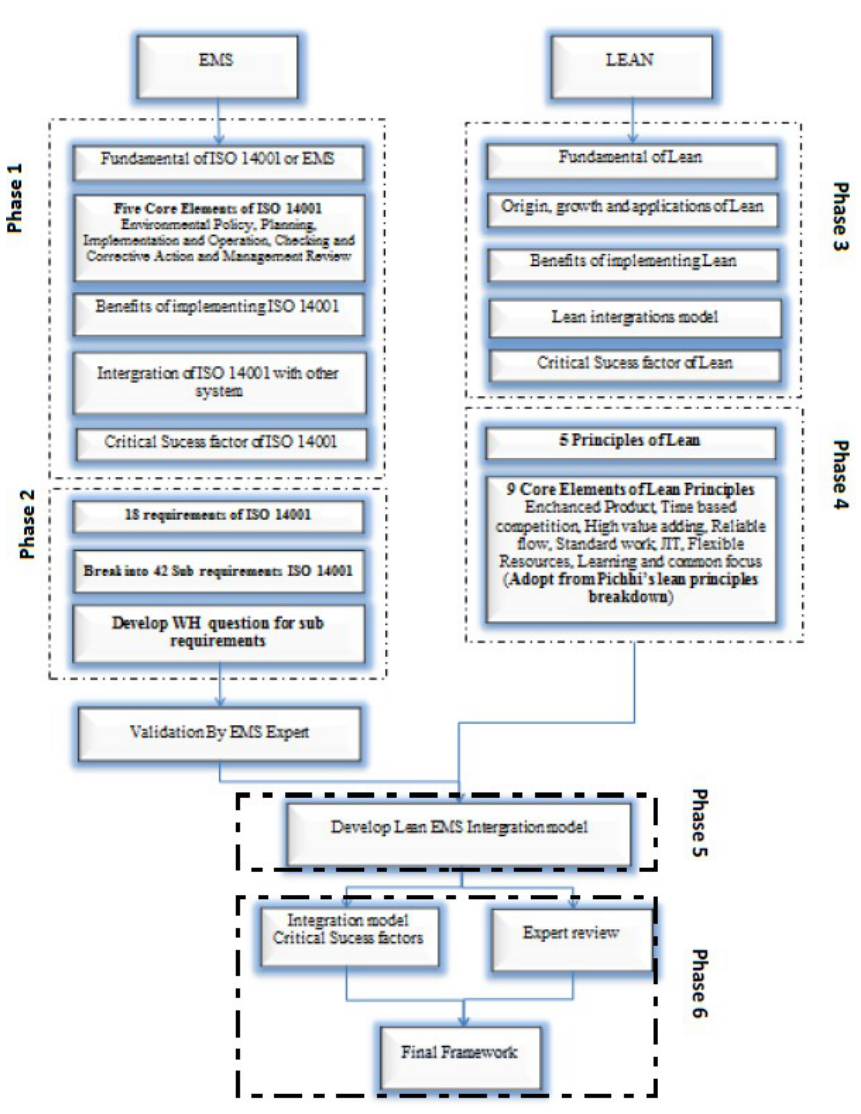
Figure 1. Framework Development